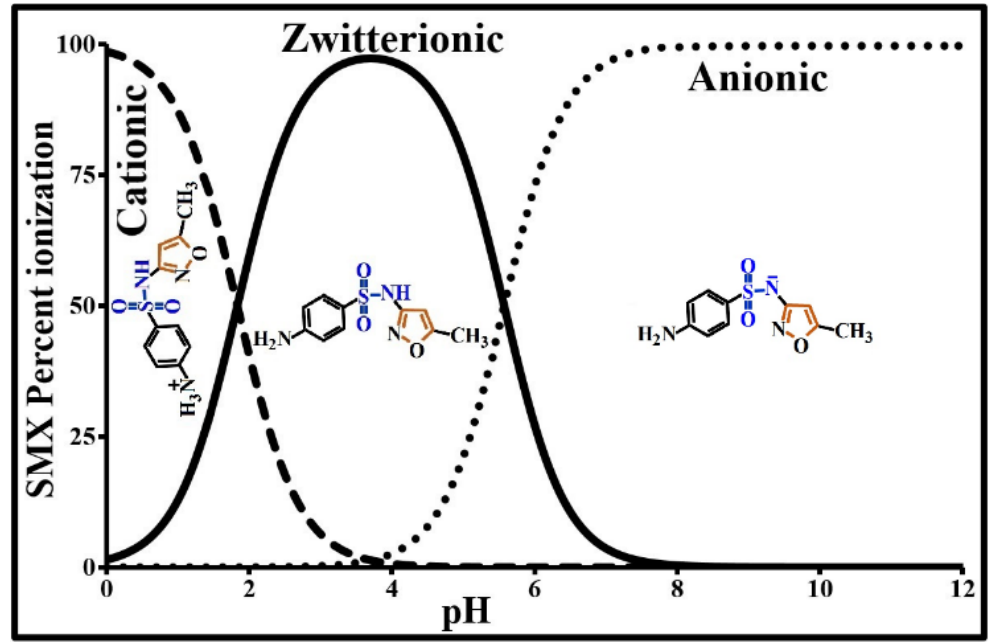
Figure 1. Sulfamethoxazole (SMX) speciation as a function of pH in aqueous solution.